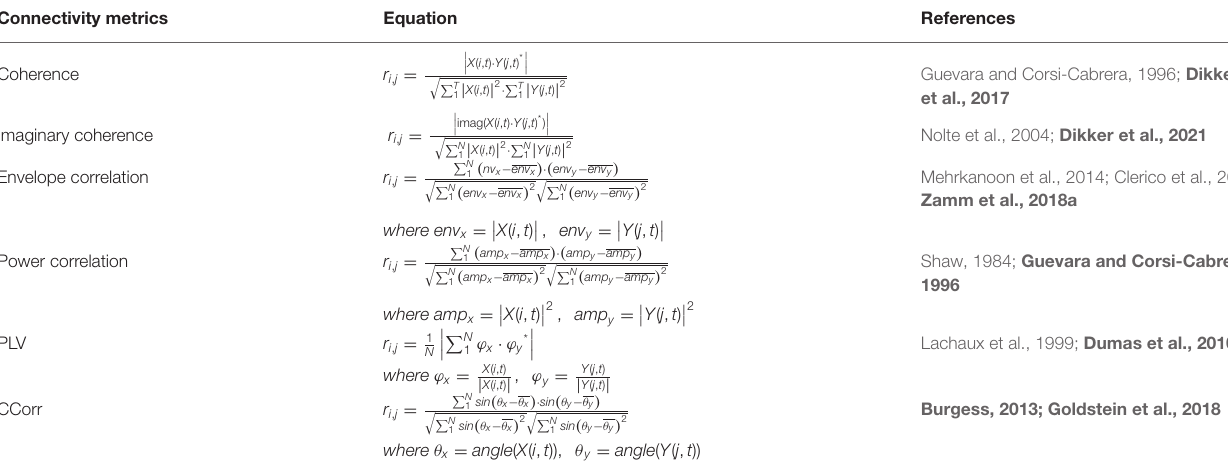
TABLE 1 | Connectivity metrics adapted from Ayrolles et al. (2021). Connectivity metrics